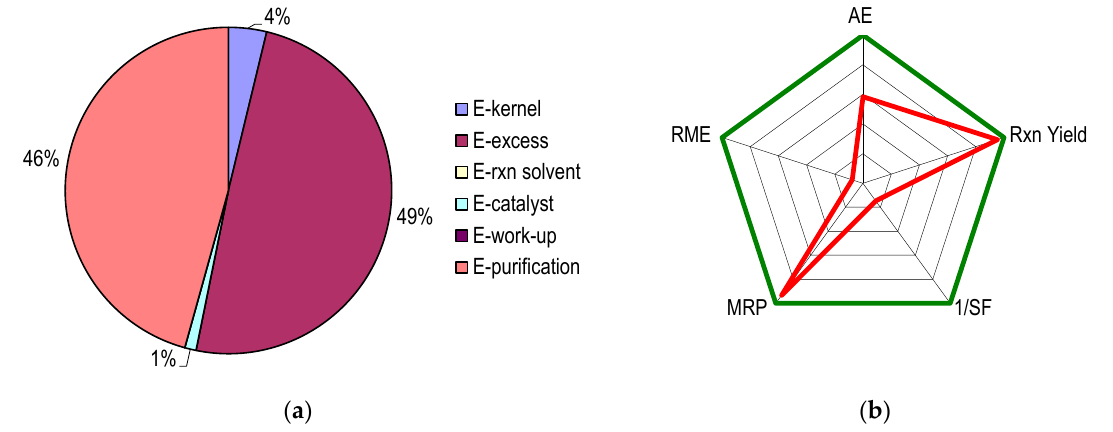
Figure 1. ( a ) E-factor profile; ( b ) radial-pentagon diagram with metrics (%): reaction yield, atom economy (AE), reaction mass efficiency (RME), materials recovery parameter (MRP), inverse of stoichiometric factor